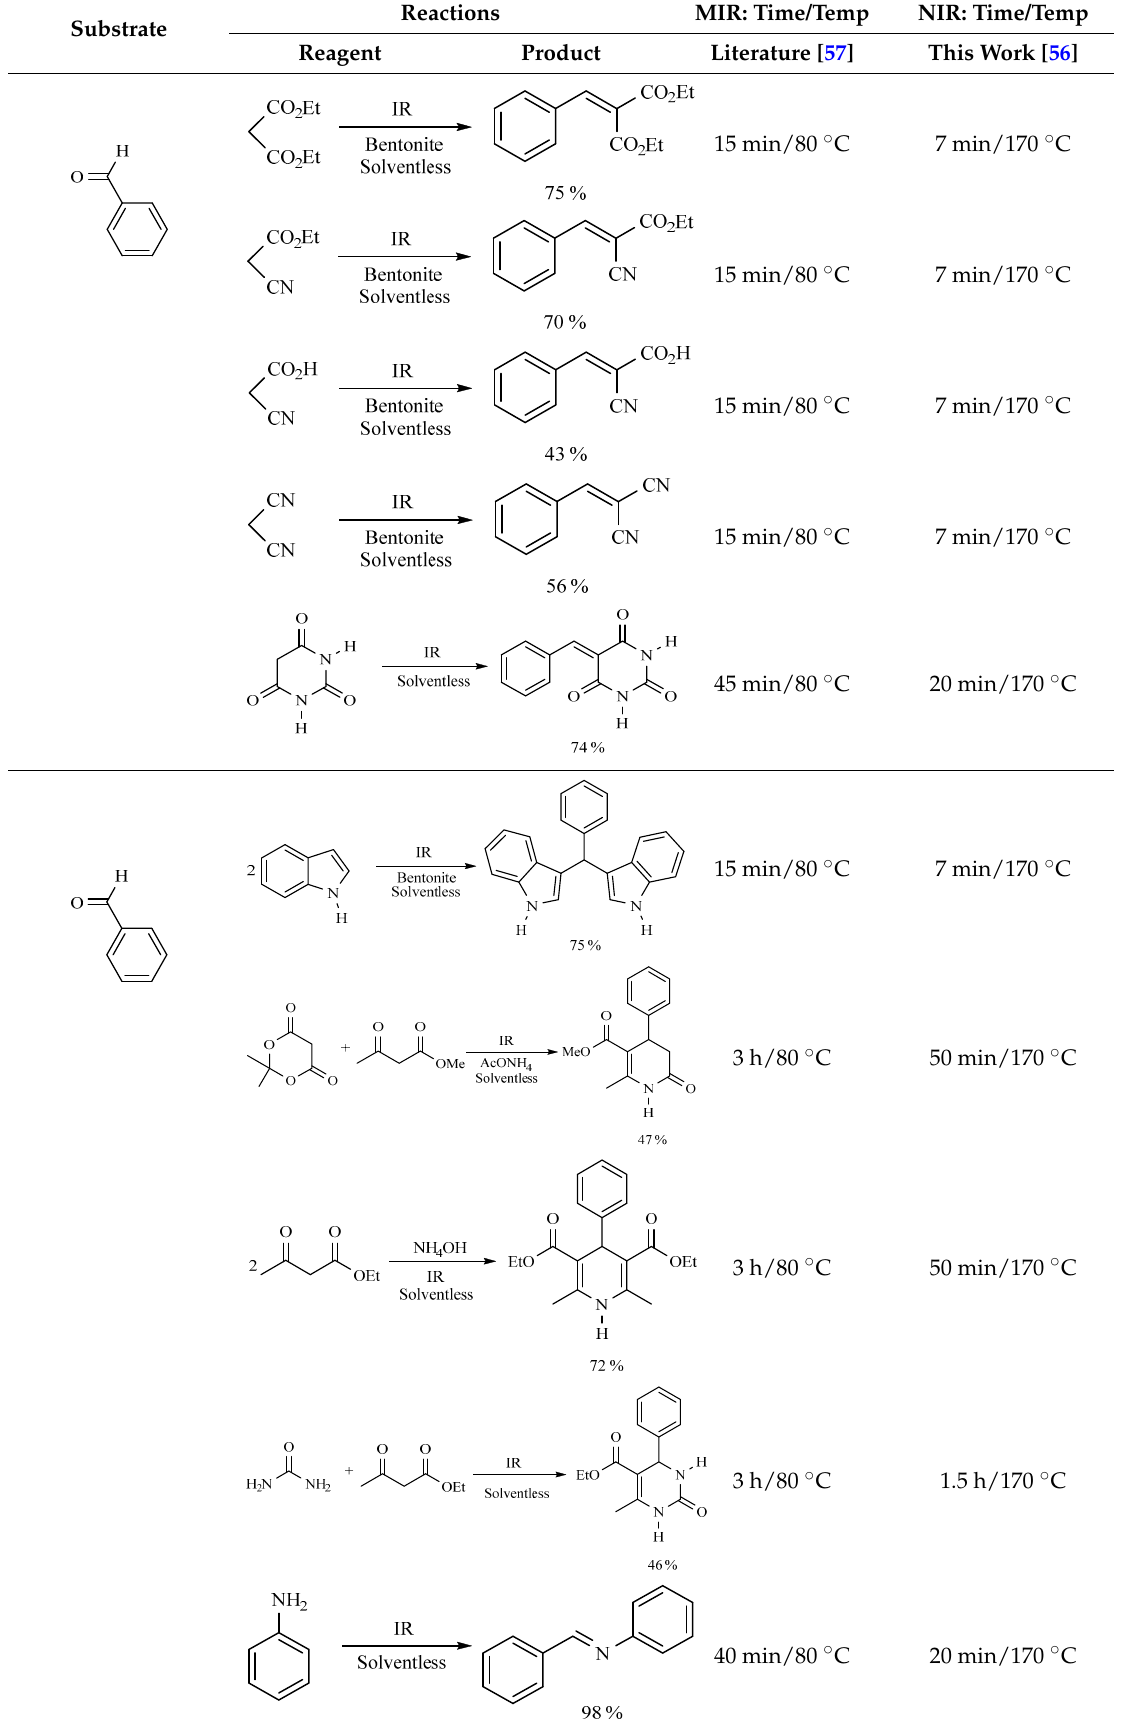
Table 1. Near vs. middle infrared irradiation for the completion of organic reactions.